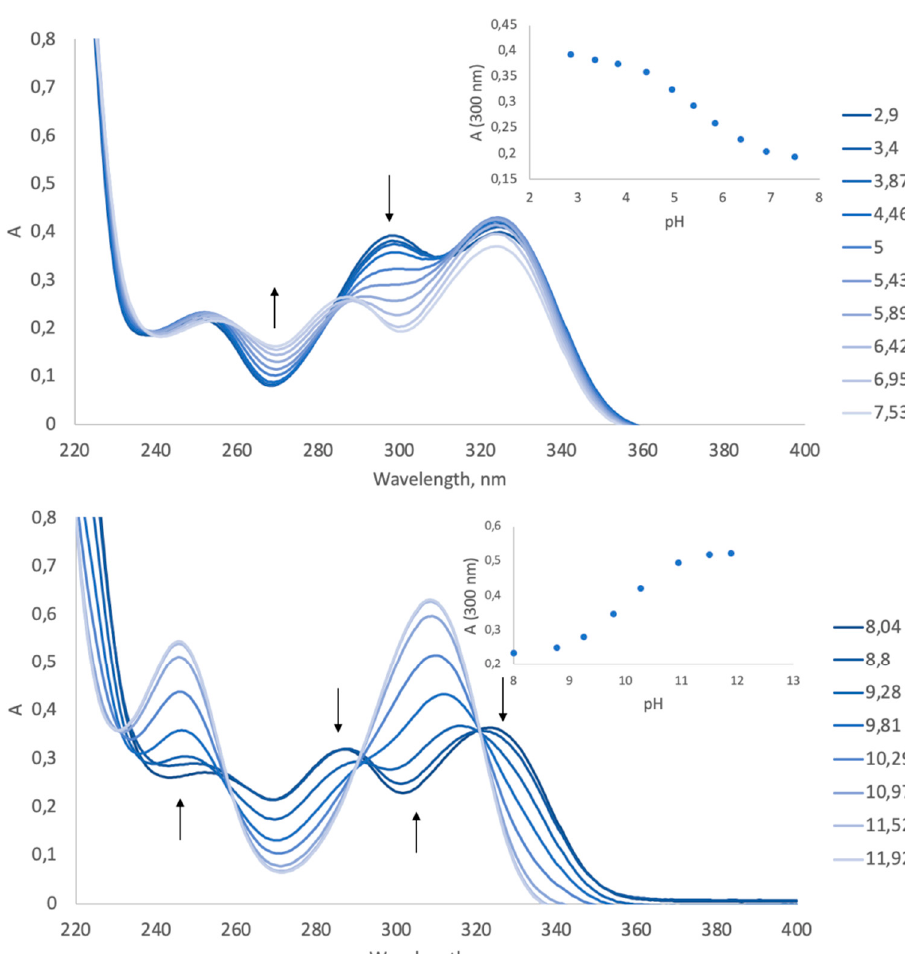
Figure 4. Evolution of the UV spectrum of Pyr-CS (0.125 mg/mL) with changing pH.